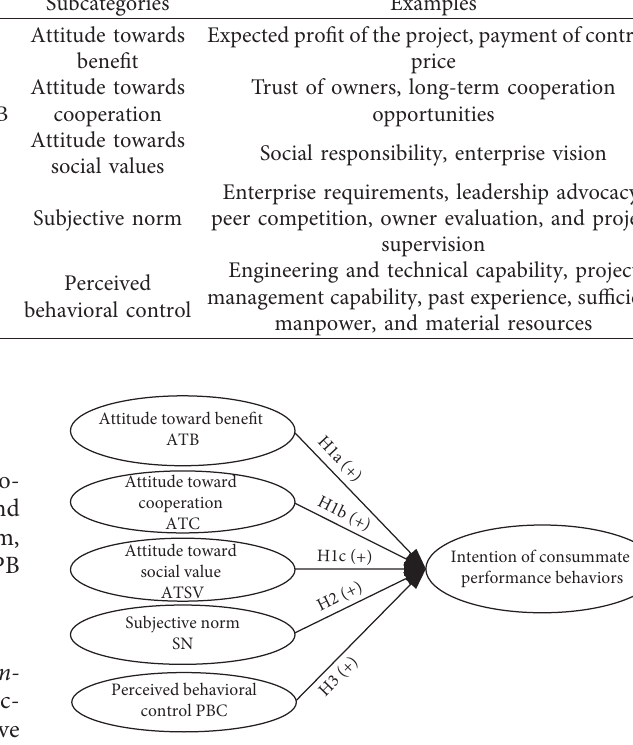
Figure 1: Conceptual model of the intention of consummate performance